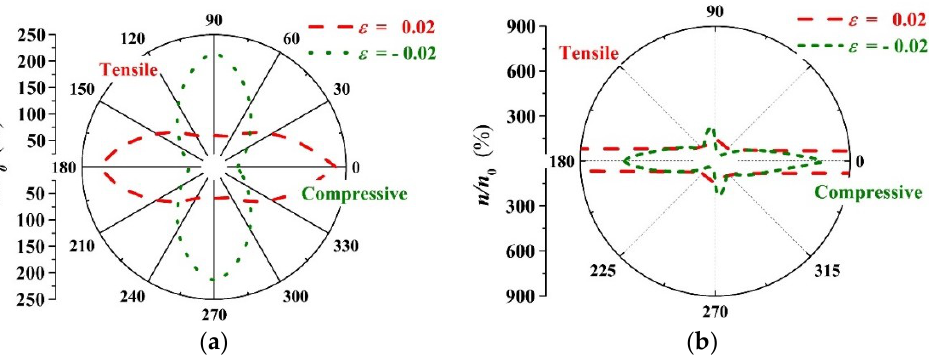
/ n n for Figure 9. The orientation distribution curves of intrinsic charge carrier concentration ratio n / n 0 for 0